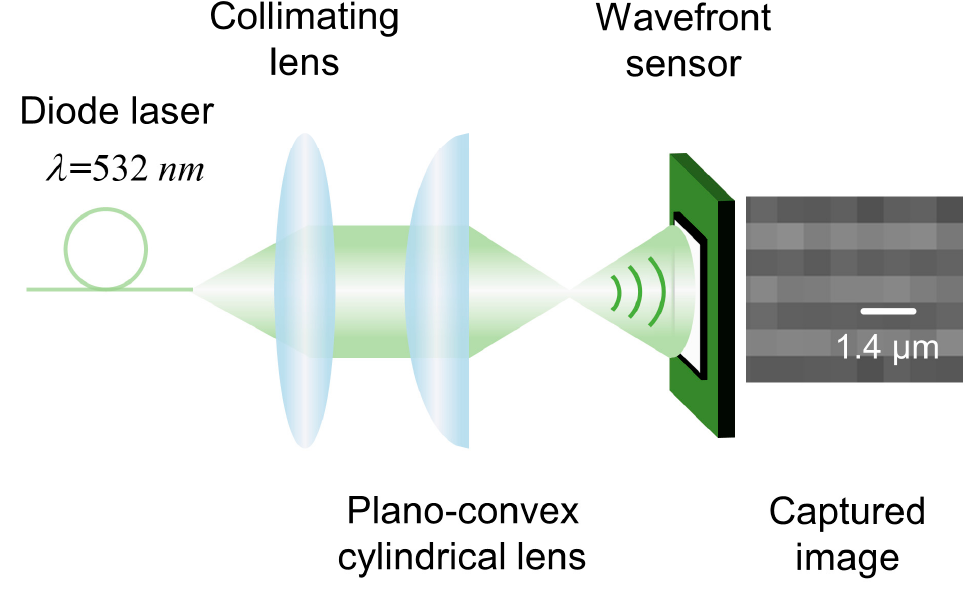
Figure 2. Schematic diagram of the experimental setup for characterizing the performance of the wavefront sensor.